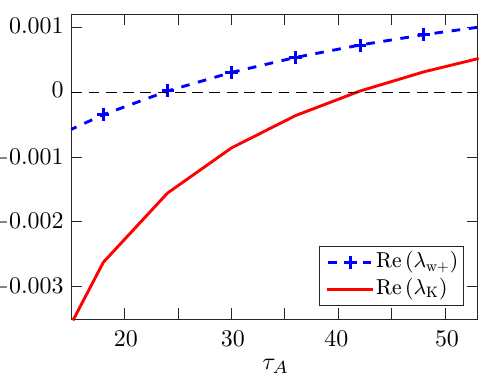
Fig. 5. An illustration of the power spectral density that is cal- Figure 5: An illustration of the power spectral density that is calcu- culated using Eq. (34). The dashed line corresponds to the min- lated using Eq. (34). The dashed line corresponds to the minimum imum frequency offset of the continuous spectrum which equals frequency offset of the continuous spectrum which equals A 2 A 2 / (4 π ) . 0